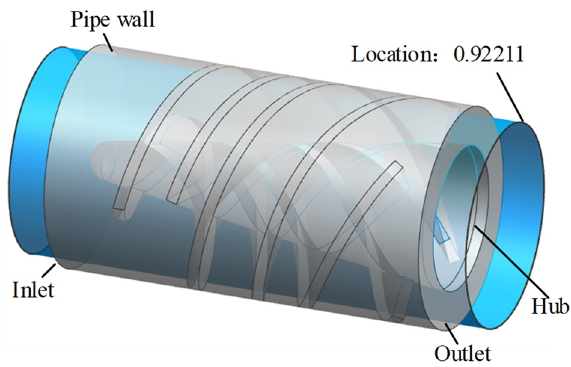
Figure 7. Position of the expansion surface of the inducer cascade. Through numerical calculation, the head distribution diagrams under 8 tip clearance conditions are obtained, which is drawn in Figure 8.